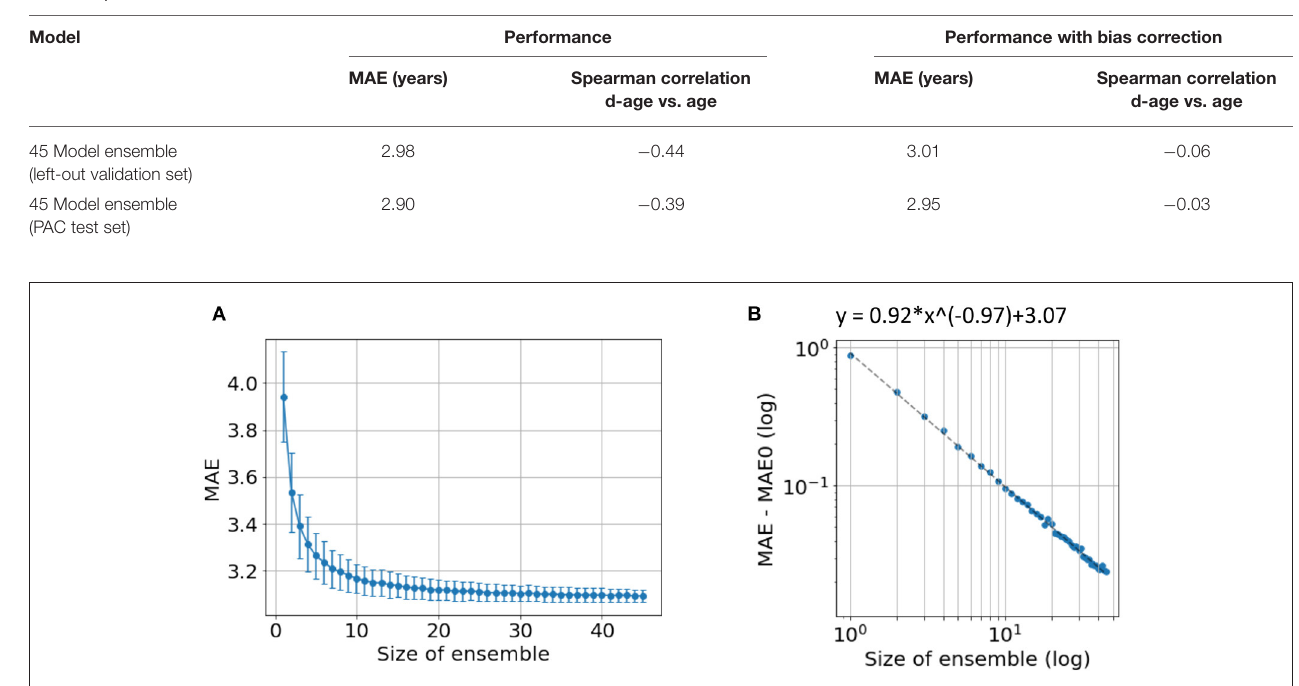
FIGURE 6 | Ensemble performance with different number of models. (A) Average performance in MAE with different number of models used by ensemble. The mean and standard deviation come from 1,000-time bootstraps. (B) The fitted line of a power law. MAE 0 is the critical point if an infinite number of models are used to form the